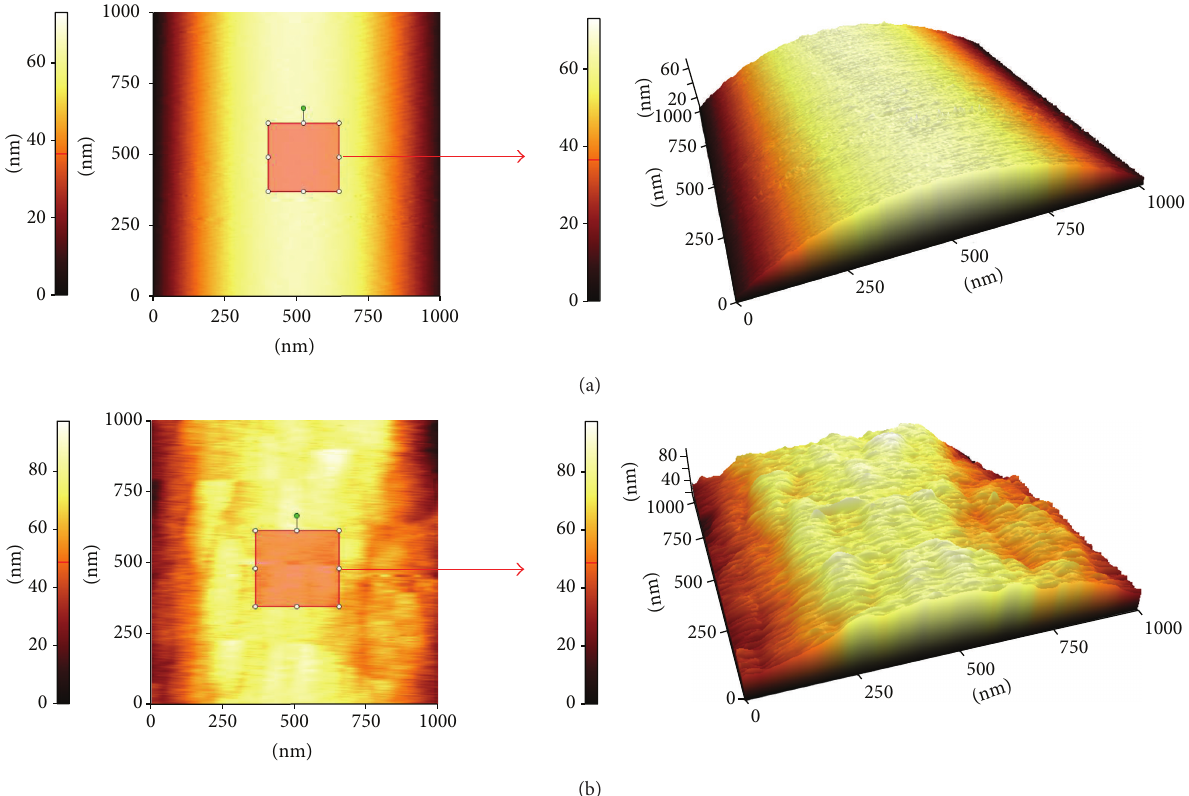
Figure 6: (a) The AFM images of the surface morphologies of a 1.5 𝜇 m-diameter microfiber; (b) the AFM images of the surface morphologies of a 1.5 𝜇 m-diameter microfiber with nanoscale-structured